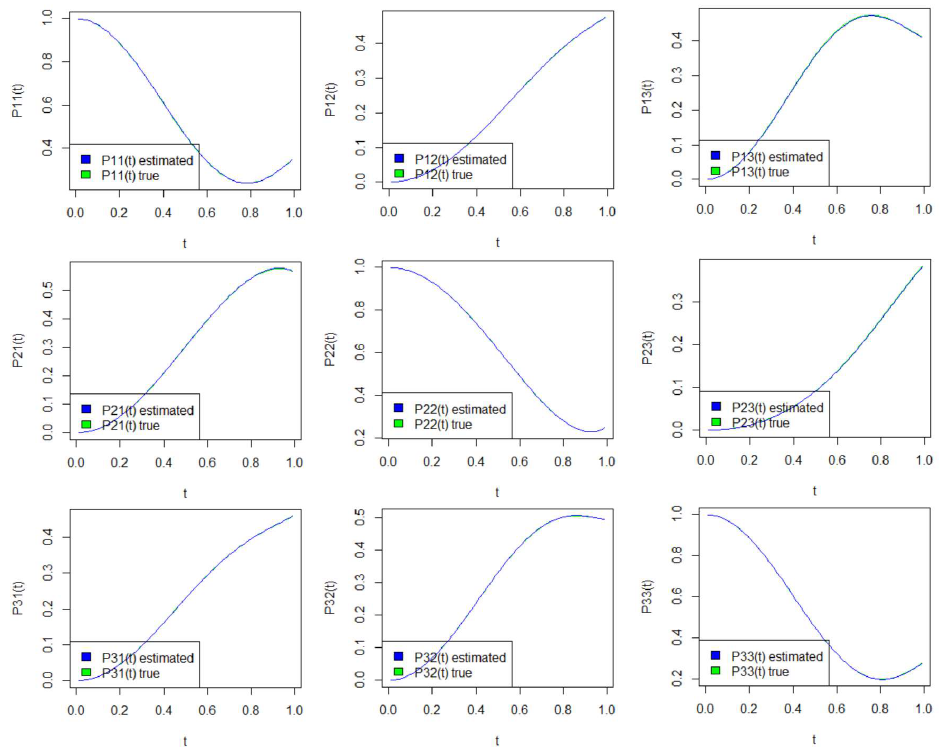
Figure 2. Real and estimated semi-Markov transition probabilities in the case of censored trajectories Table 9. Estimators for the transition probabilities of the semi-Markov process for t = 0.1 and t = 0.5. ˆ P ij ( t = 0.1)